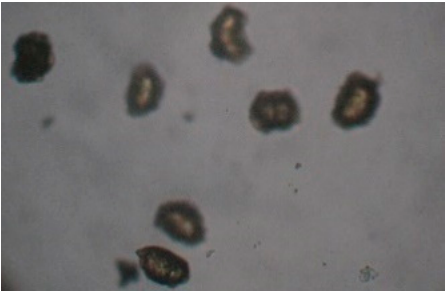
Figure 5. Dryopteris affinis —ungerminated spores EAN variant (100),